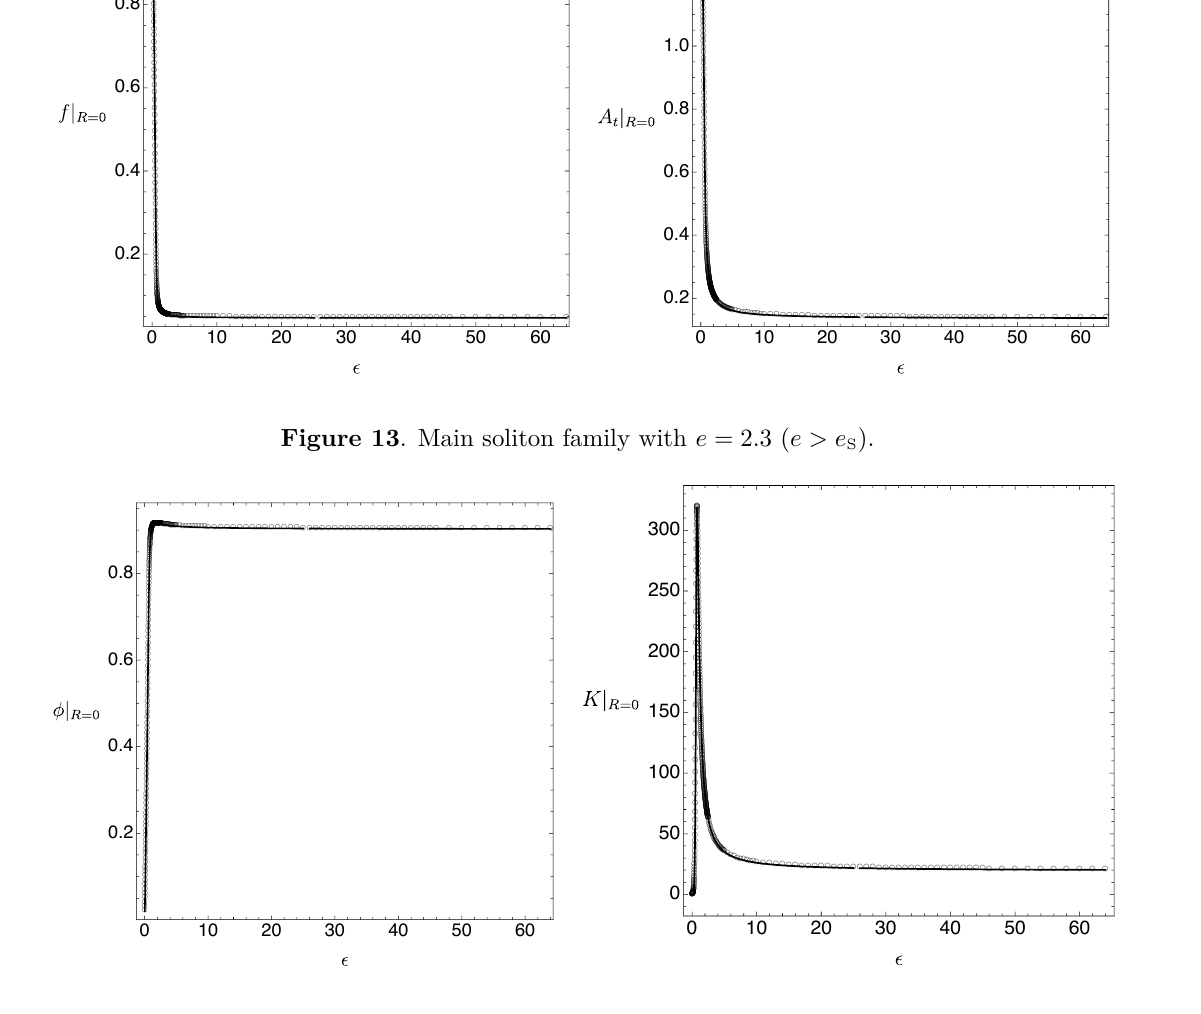
Figure 14 . Main soliton family with e = 2 . 3 ( e > e